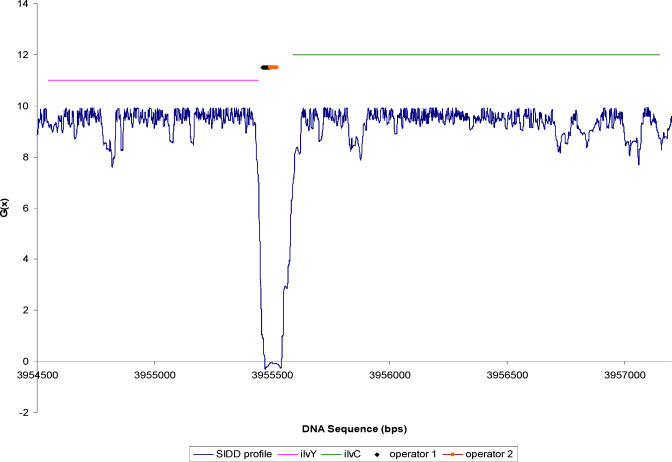
SIDD Profile of the Genomic Region Containing the Gene for the LysR-Type Transcription Regulator ilvY and its Target Gene ilvC
These form a divergently oriented gene pair that are known to be coordinately regulated by transcriptional coupling [53].